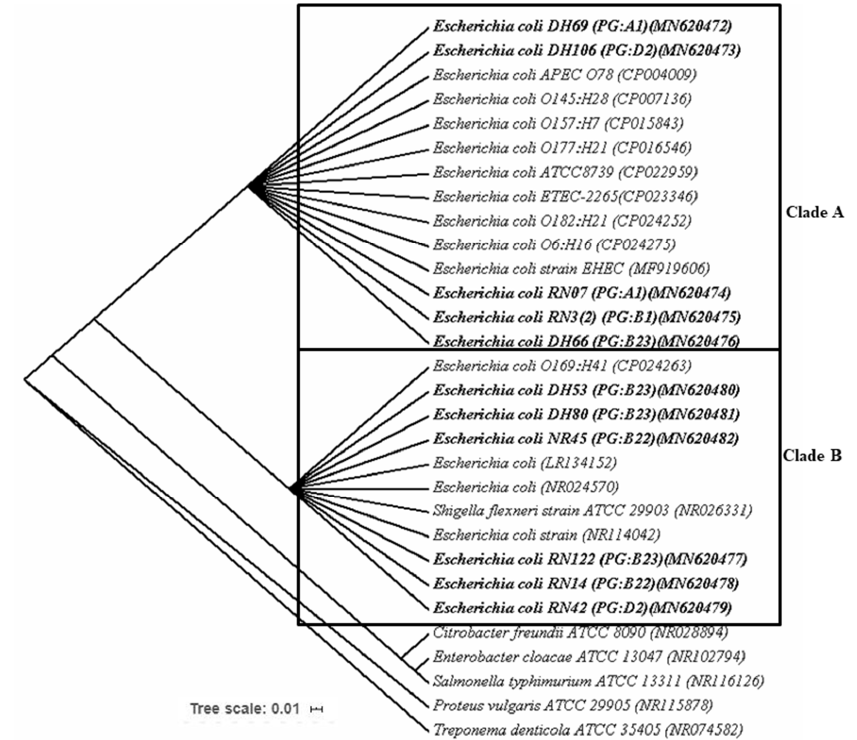
Figure 6. Phylogenetic tree predicted by the neighbor‐joining method using 16S rRNA gene sequences. The evolutionary distances were computed using the Kimura two‐parameter model method. The bootstrap considered 1000 replicates. The scale bar represents the expected number of substitutions averaged over all the analyzed sites. The optimal tree with the sum of branch length = 0.35475560 is shown here. Treponema denticola was used as out group. The length of the scale bar represents one nucleotide substitution per 100 positions.